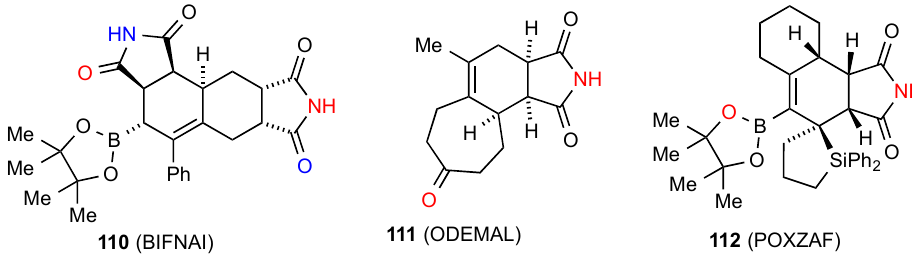
Figure 37. Six-membered ring-fused succinimides showing patterns H and D.